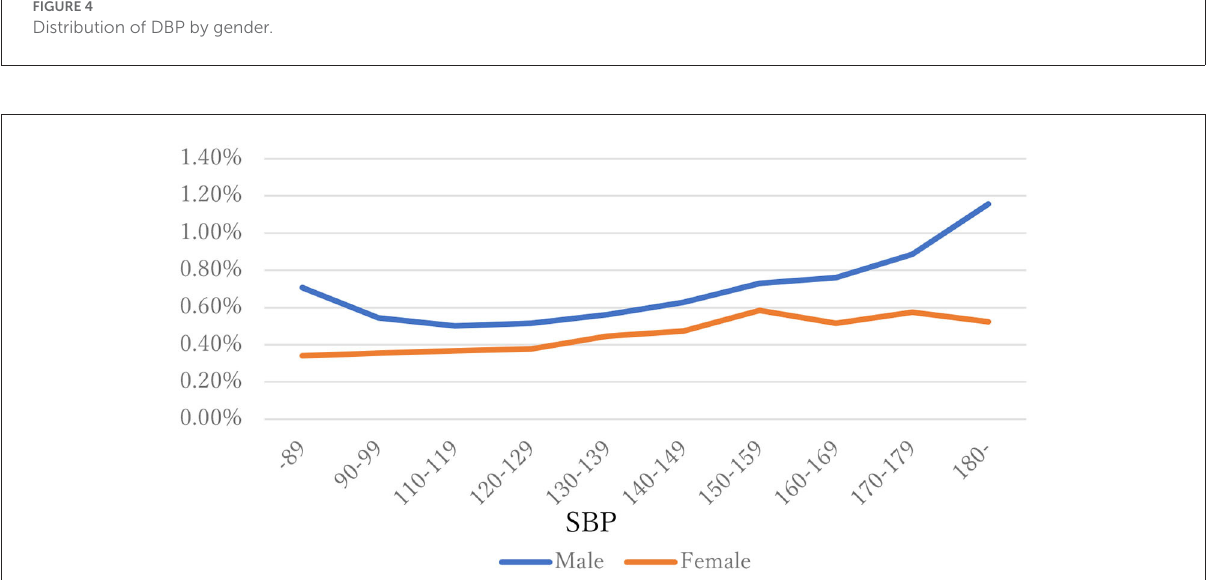
FIGURE5 SBP and percentages having HD by next year by gender.